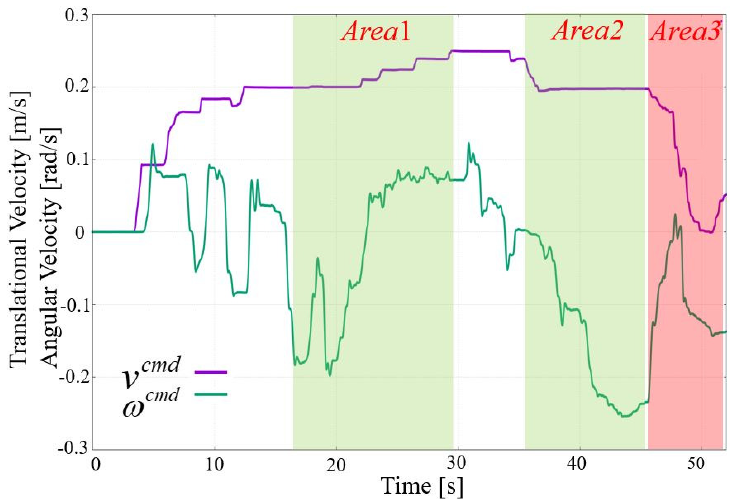
Figure 16. Experimental results of velocity of Case 3 for Subject